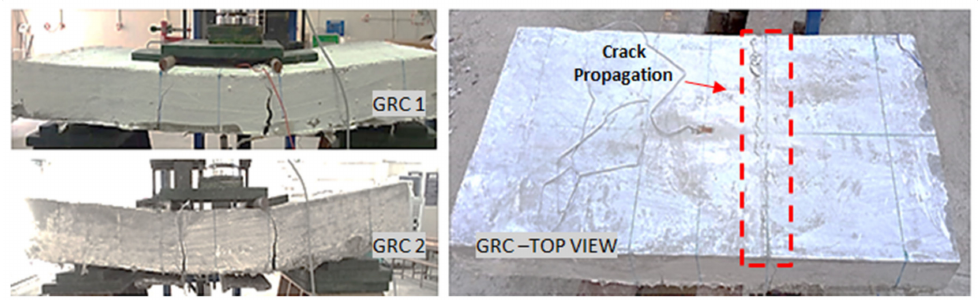
Figure 4. Crack pattern and failure mode of SRF slab.